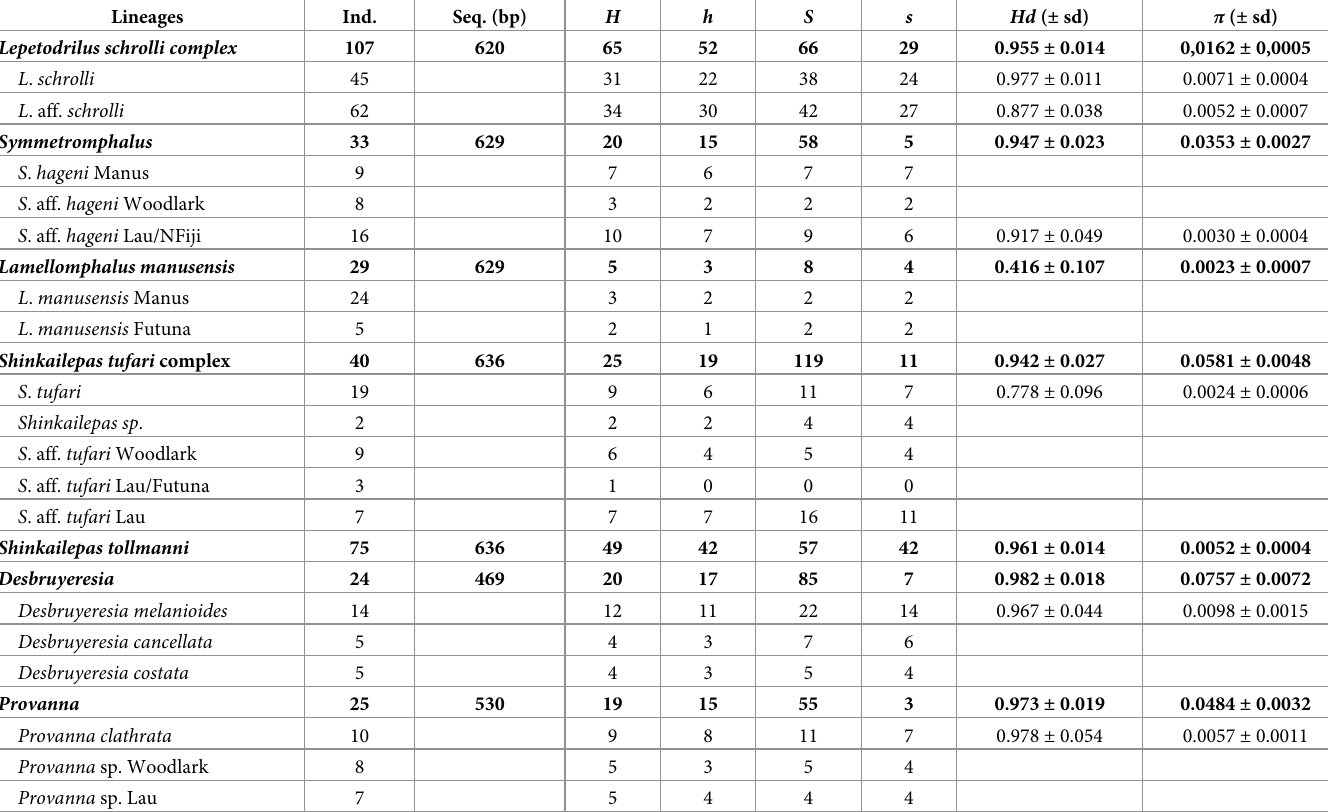
Table 4. Variation among Cox1 nucleotides sequences for each taxon and lineages.